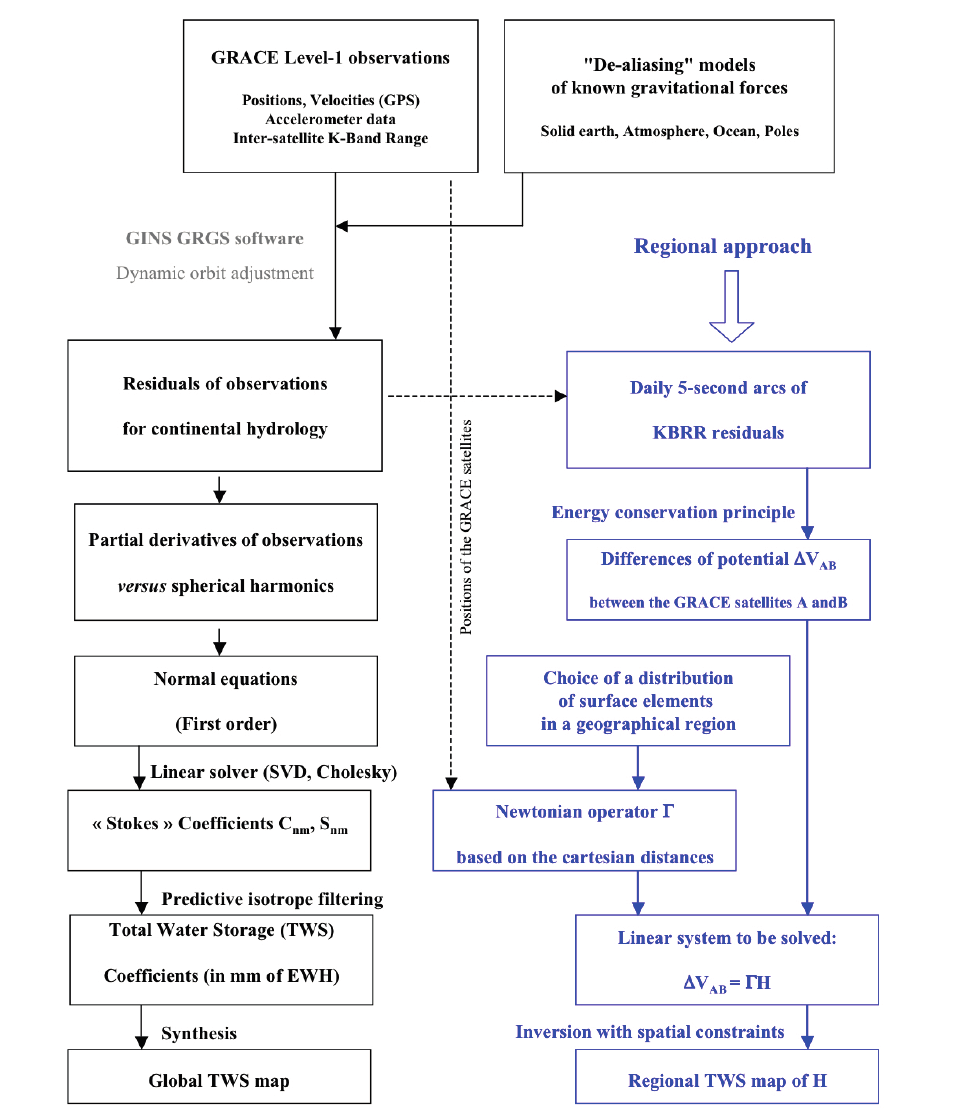
Figure 2. Schematic view of the processing for estimating global and regional solutions from a given 10-day or monthly period of Gravity Recovery and Climate Experiment (GRACE) observations. GINS, Géodésie par Intégrations Numériques Simultanées; GRGS, Groupe de Recherche en Géodésie Spatiale; SVD, singular value decomposition; KBRR, K-band range